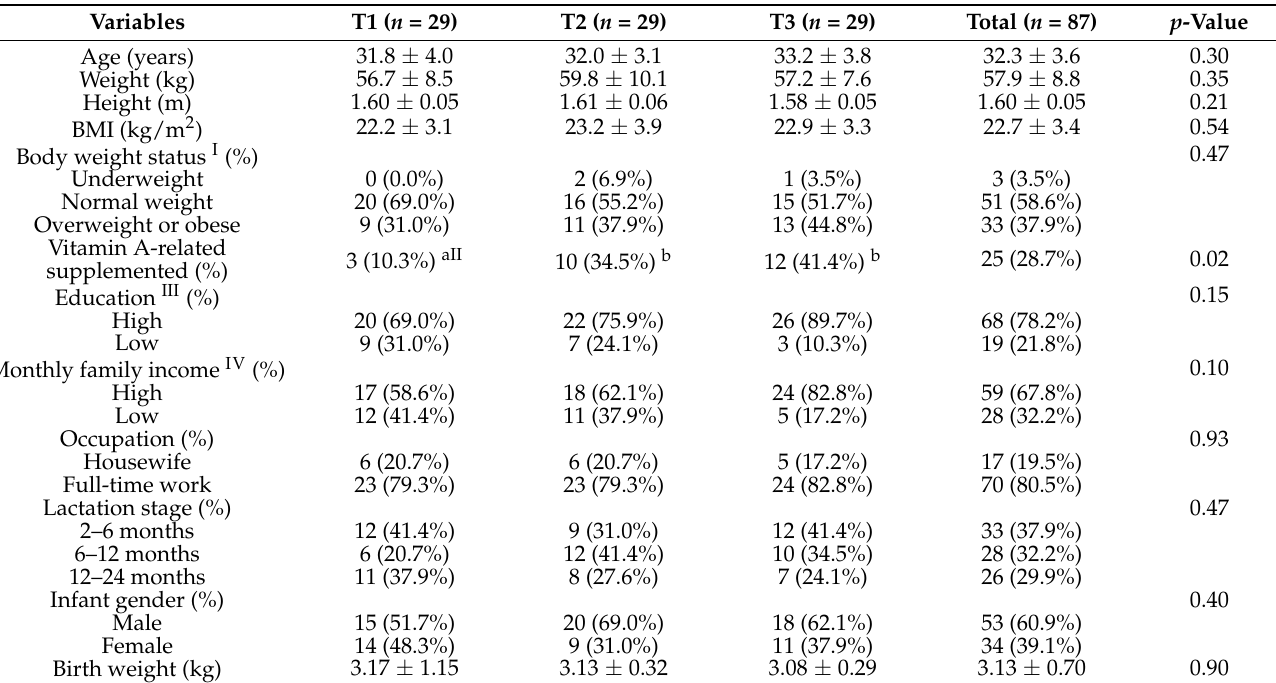
Table 1. Anthropometric and socioeconomic characteristics of 87 Hong Kong lactating